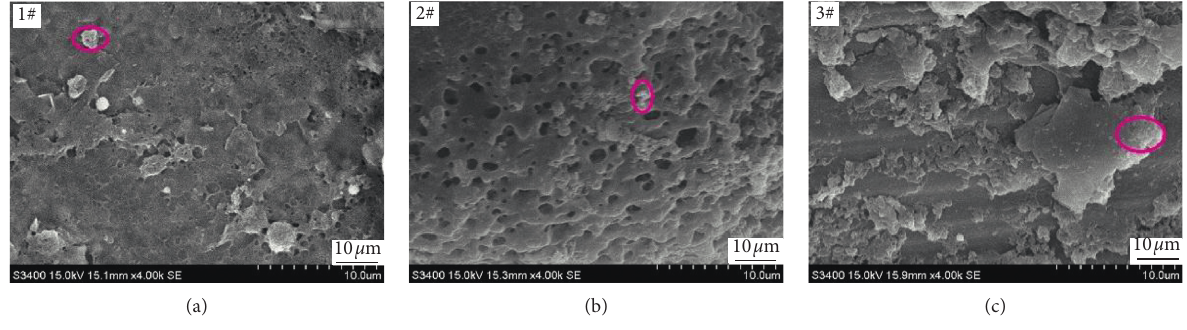
Figure 6: Fracture morphology observed by SEM.